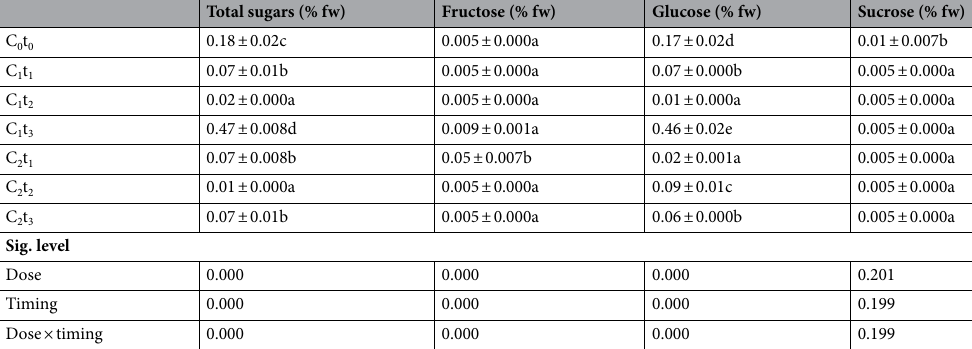
Table 3. Sugar composition of P. ostreatus mushrooms cultivated on supplemented substrates. C 1 3 g kg −1 , C 2 g kg −1 , t 1 supplementation at spawning, t 2 supplementation after the first harvest, t 3 supplementation at spawning and after the first harvest. Values are means; means within the same column followed by the same letters are not significantly different at P < 0.05 according to Duncan’s multiple range test.